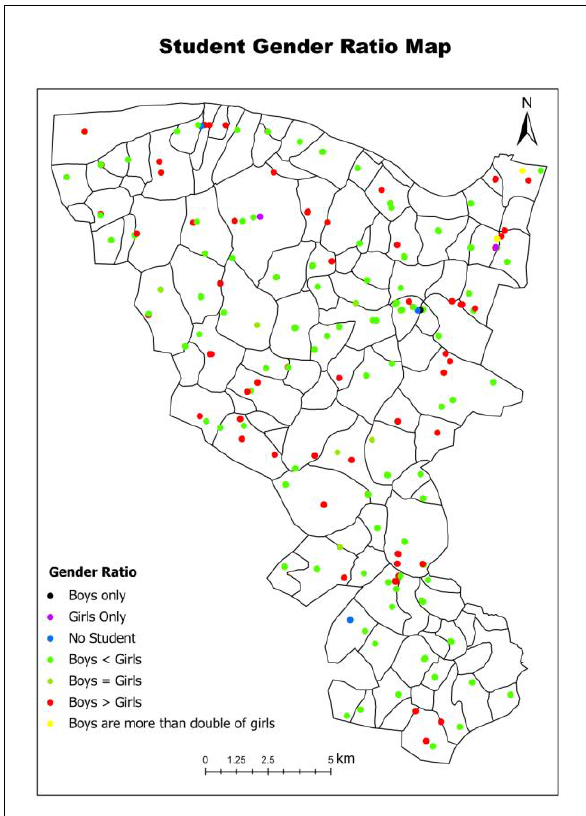
Figure 5. Boys and girls ratio in school